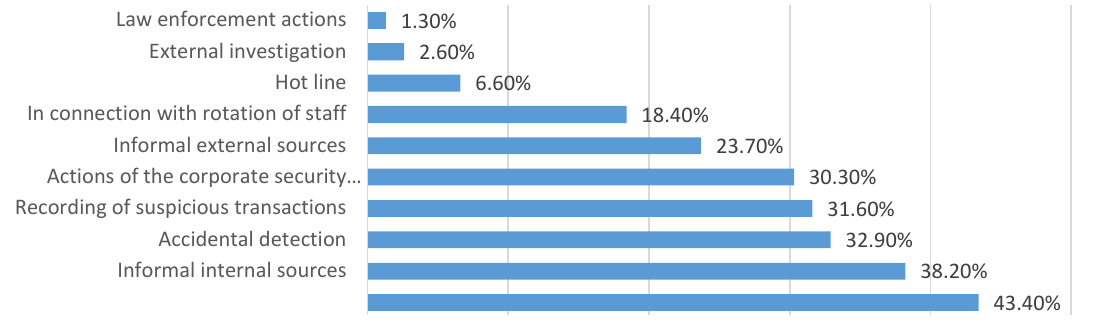
Figure 2. Cases of swindling disclosures at Ukrainian enterprises, 2016